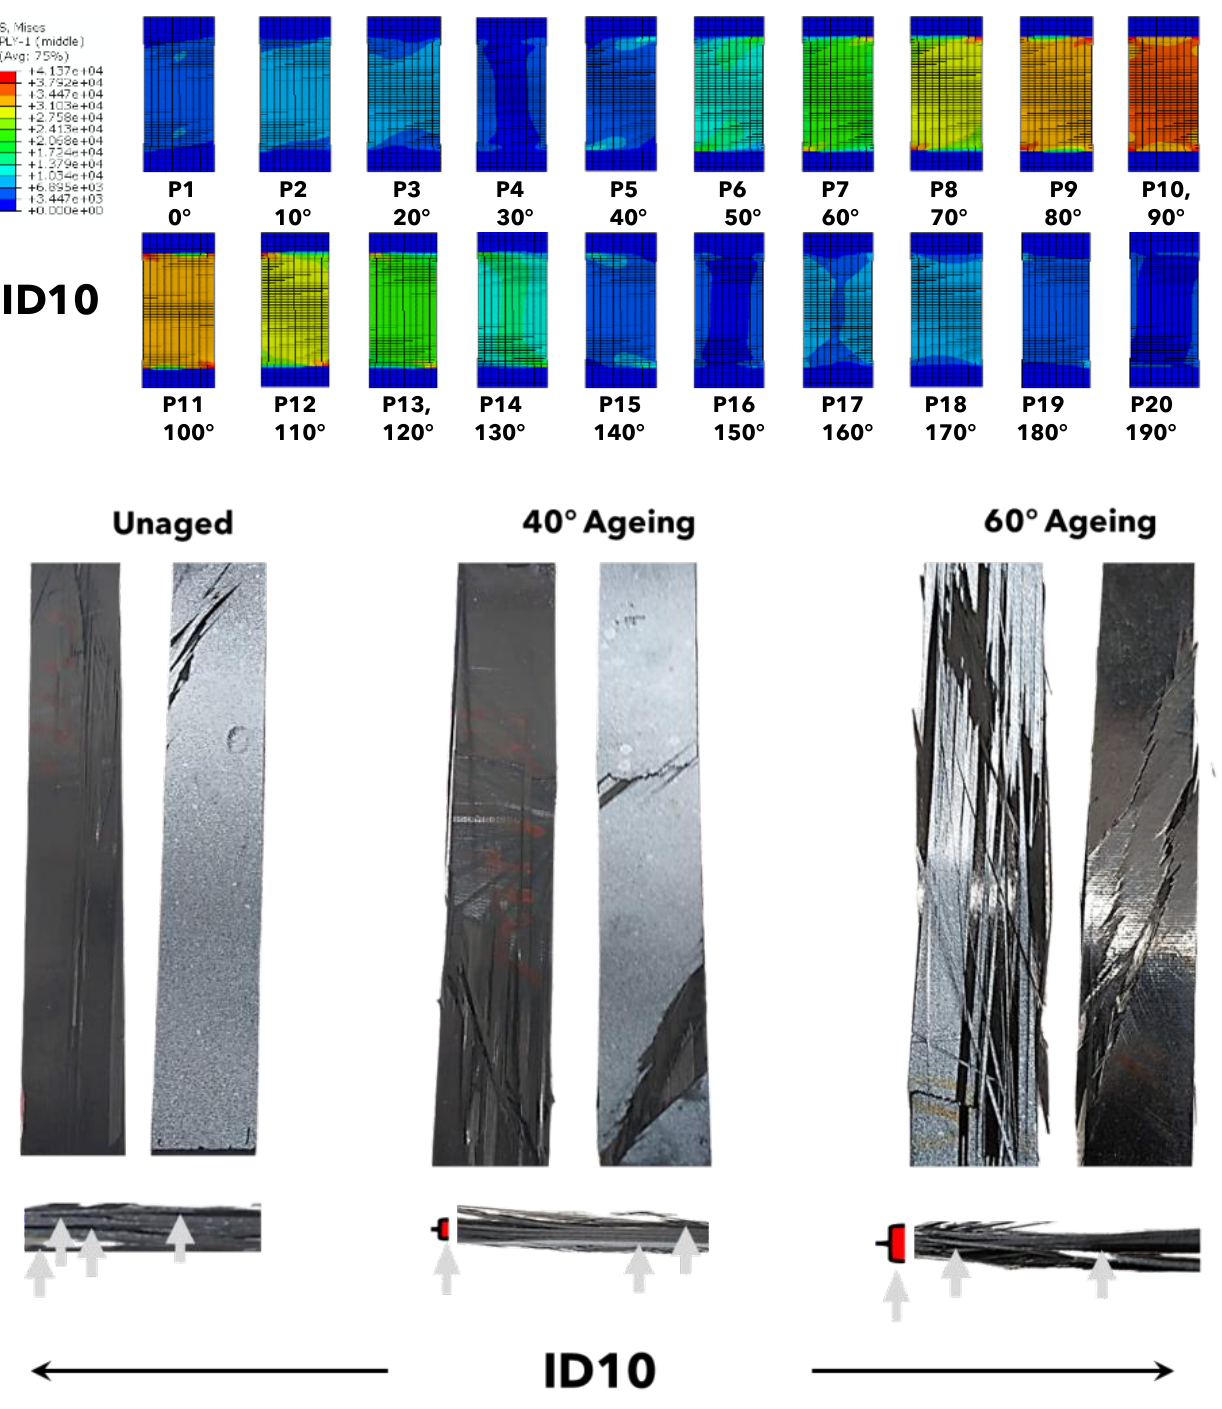
Figure 7. Stress (von Mises) distributions in individual dry plies predicted using the Hashin failure model, for ID10 composites ( top ), front and back face fractures from representative dry, 40 ◦ C, and 60 ◦ C aged samples ( middle ), and side view fractures from representative dry, 40 ◦ C, and 60 ◦ C aged samples ( bottom ), with arrows indicating the primary areas of fracture